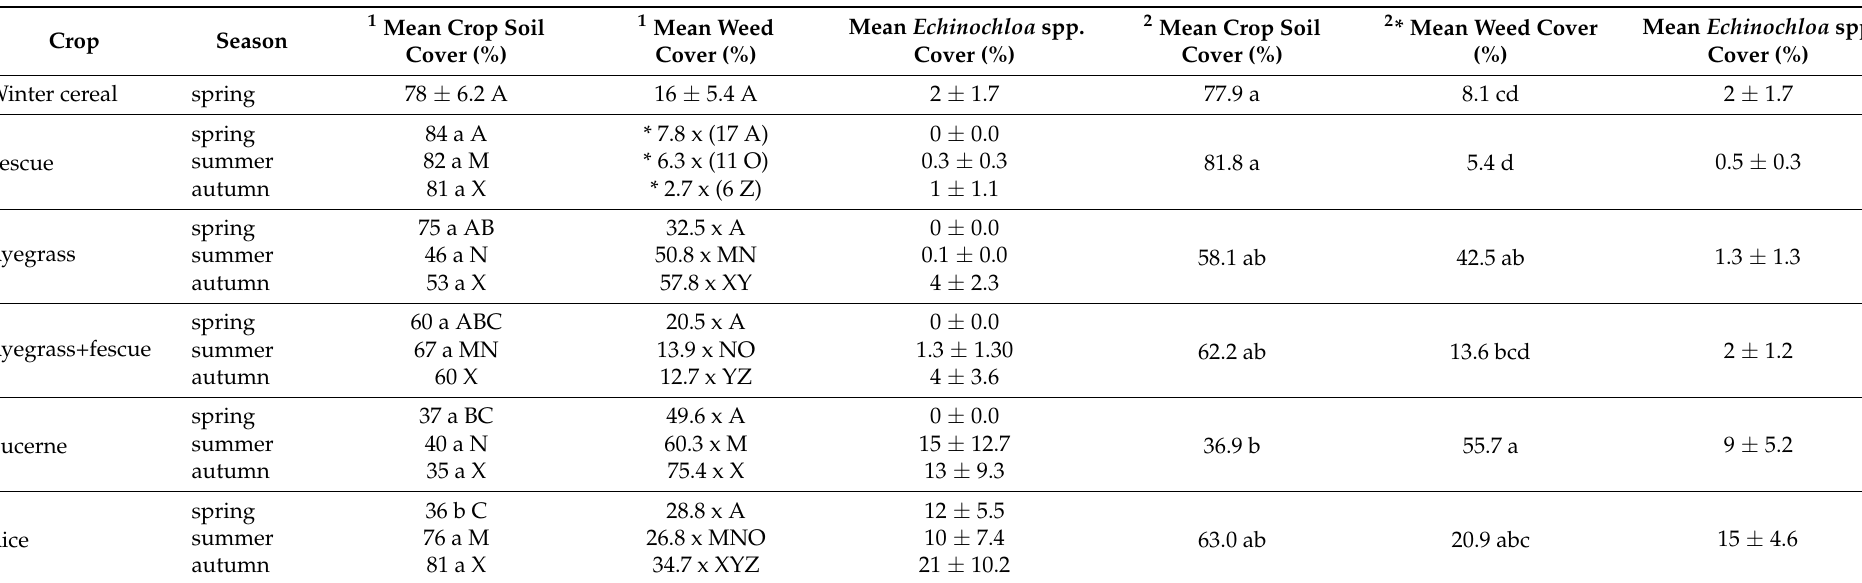
Table 5. Mean crop soil cover, weed soil cover and Echinochloa spp. cover (%) for the different crops repeated during 2014 to 2016 in the different seasons and yearly mean ± standard error for the same values. Winter cereal was not surveyed after harvest in summer and autumn. 1 Mean Crop Soil Mean Echinochloa spp. Mean Echinochloa Crop Cover (%)